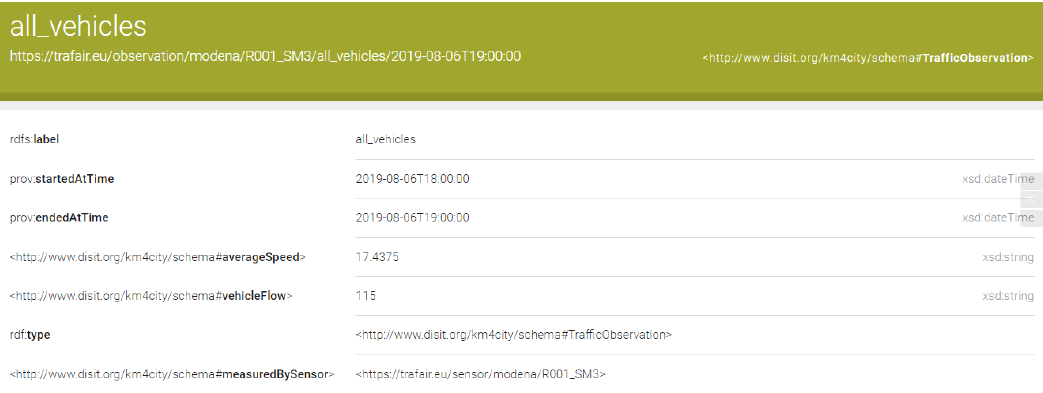
Figure 10. LodView representation of one observation made by the traffic sensor